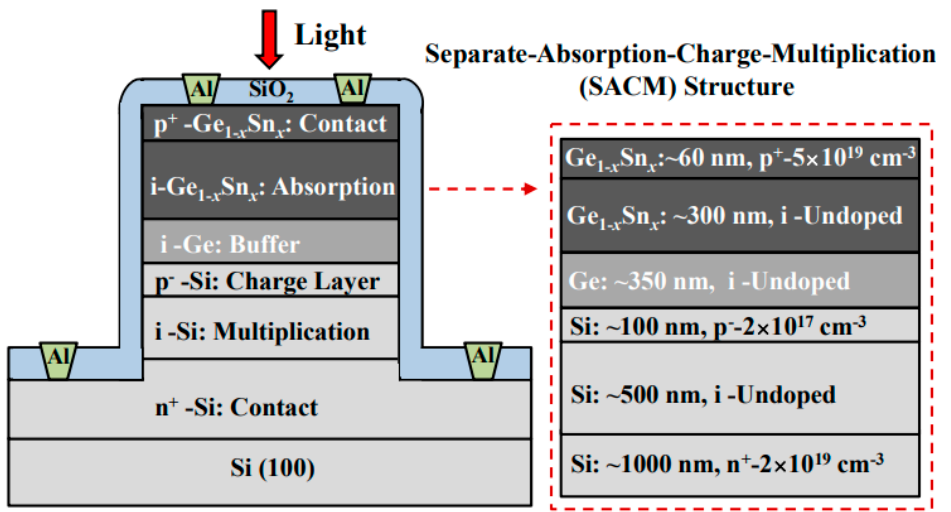
Figure 15. Schematic for first demonstration of SACM GeSn APD with Sn composition up to 5%. Reproduced with permission from [74], IEEE, 2014.